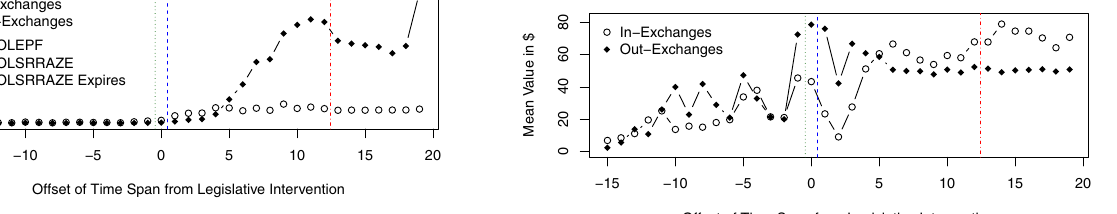
Fig. 9 In- and out-exchanges actor counts. Temporal representation of the number of actors cashing in (circles) and cashing out (diamonds) for 30- day spans. The number of actors cashing in goes up slightly after the tax- incentives are in place (span 0) but remains moderate. There is a rapid increase in actors cashing out after the incentives. The spike at the end of the project represents the remaining group of users who wanted to cash- out before the project termination. There are 2657 agents who cash-in every 30-day span from time 5 – 20. There are on average 13,070 agents during the same period who cash-out.